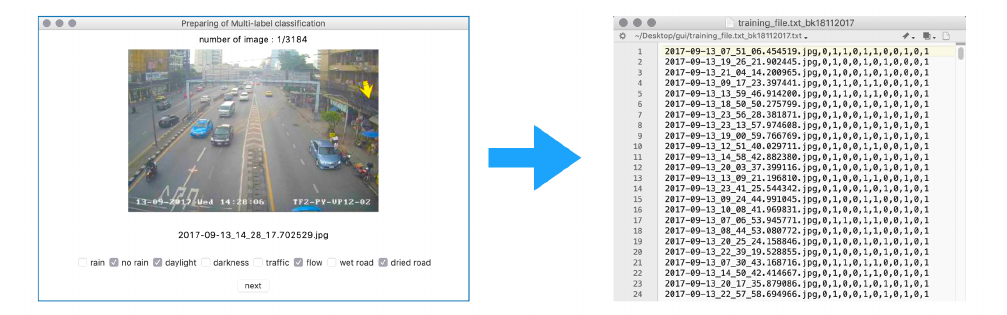
Figure 4. Assigning the one-hot label to each image.